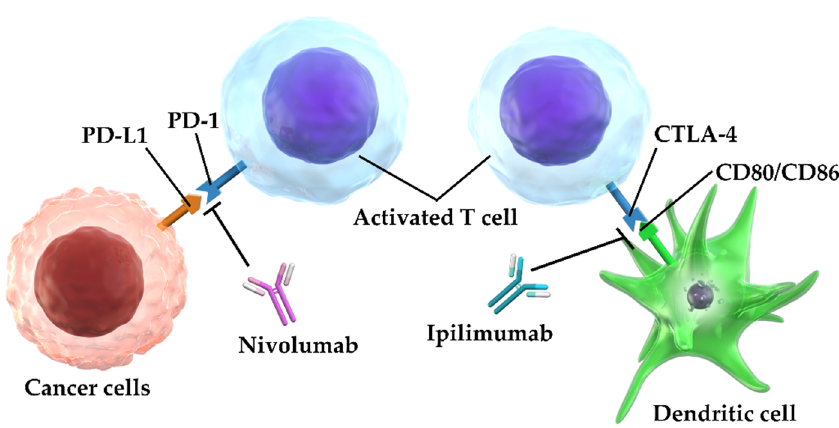
Figure 10. Ipilimumab releases T lymphocytes from suppression caused by CD80/CD86-expressing dendritic cells by competing for binding to CTLA-4 on T lymphocytes, and induces T lymphocyte activation and proliferation. Nivolumab releases T lymphocytes from suppression caused by PD-L1-expressing cancer cells by binding to the PD-1 molecule. These properties of ipilimumab and nivolumab contribute to the restoration of the antitumor effect of T lymphocytes; PD-1, programmed cell death-1; PD-L1, programmed cell death ligand 1; CTLA-4, cytotoxic T lymphocyte antigen-4.